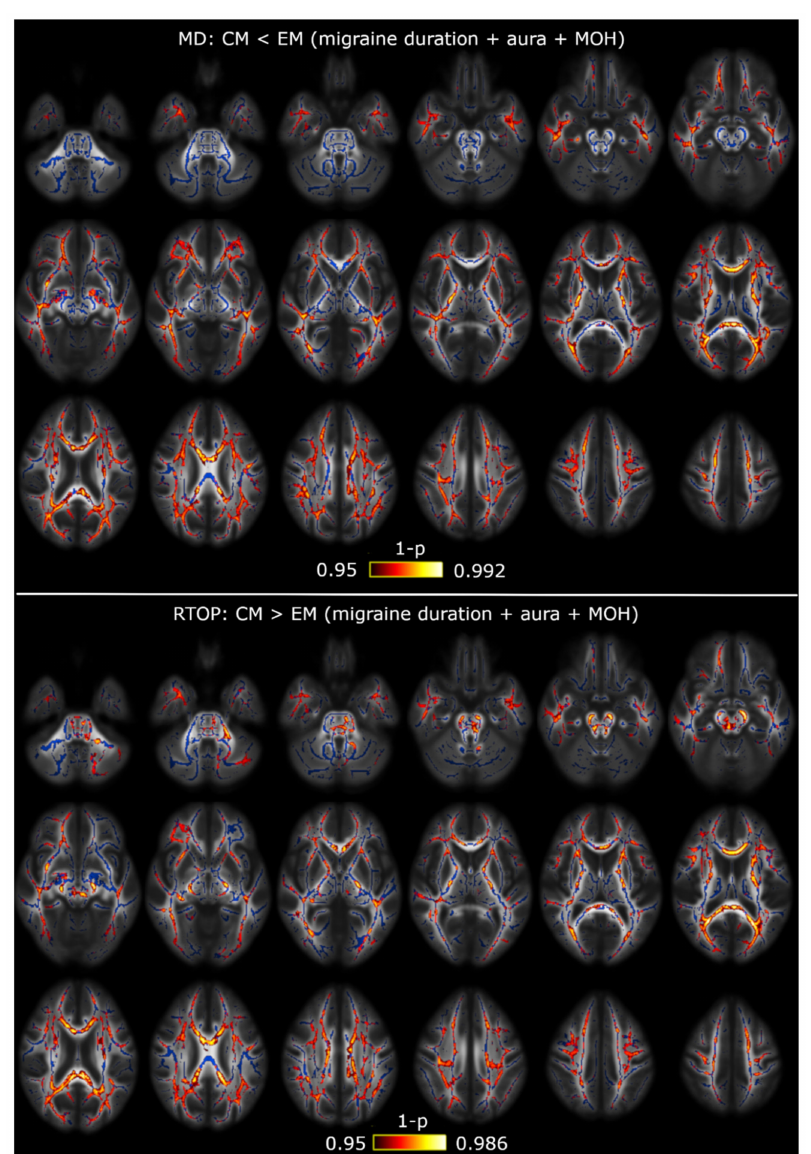
Figure A4. MD and RTOP alterations between CM and EM including the duration of the migraine, presence of aura and medication overuse headache as covariates. TBSS showed decreased MD and increased RTOP values in CM with respect to EM. The white matter skeleton is shown in blue, and voxels with the lowest p -values in red-yellow. The color bar shows the 1- p -values (FWE-corrected). MOH = medication overuse